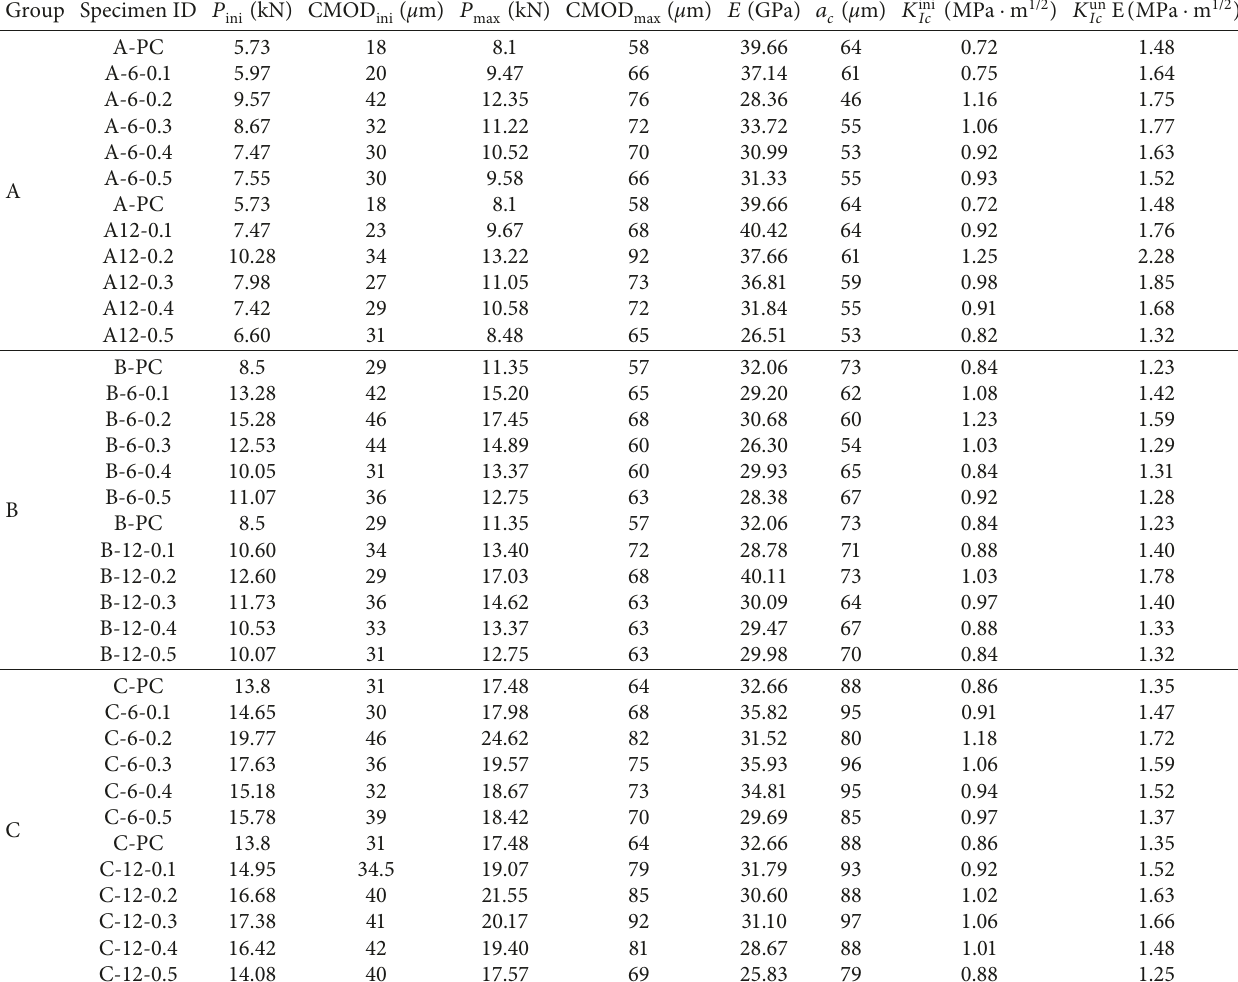
Table 10: BFRC fracture parameters with various basalt fiber content and